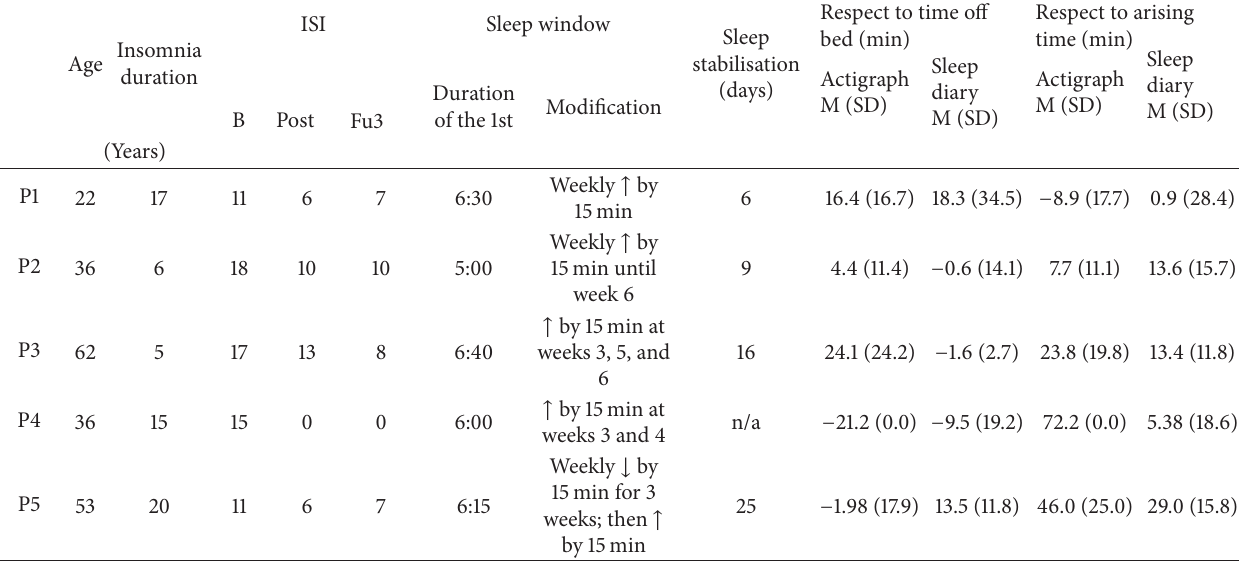
Table 3: Descriptive information of participants and treatment